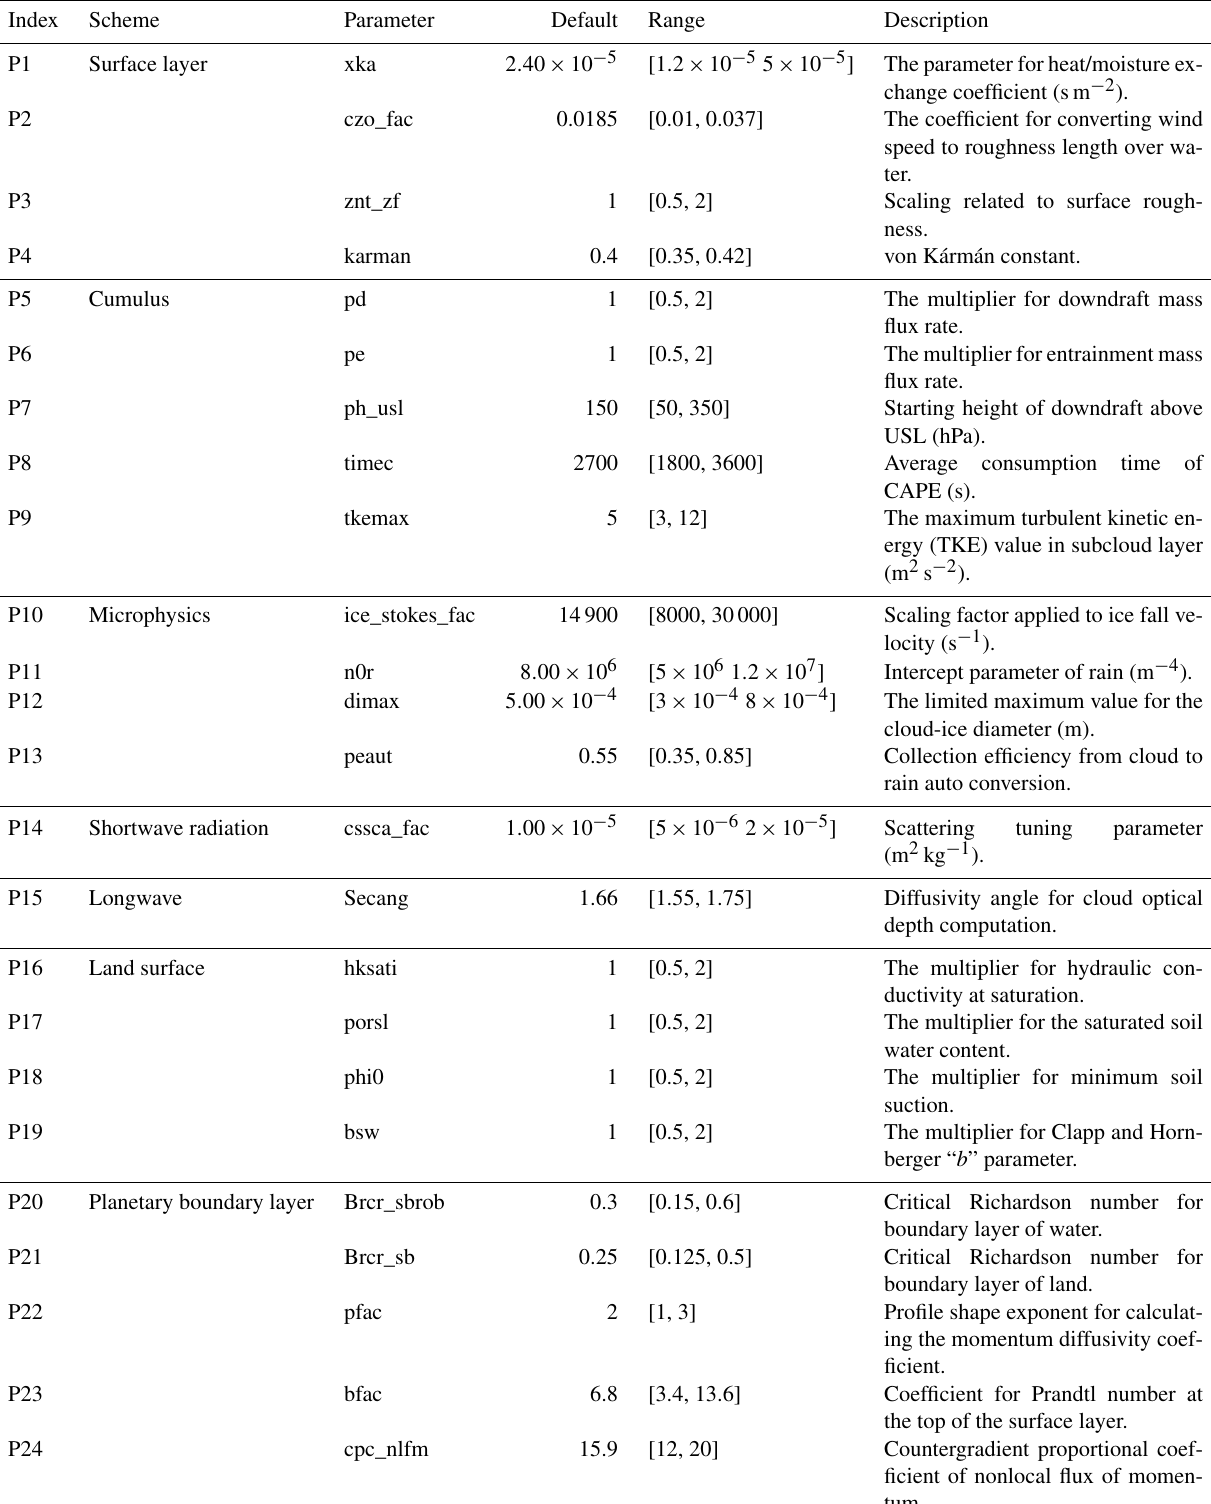
Table 1. Overview of the adjustable parameters and corresponding ranges selected in this